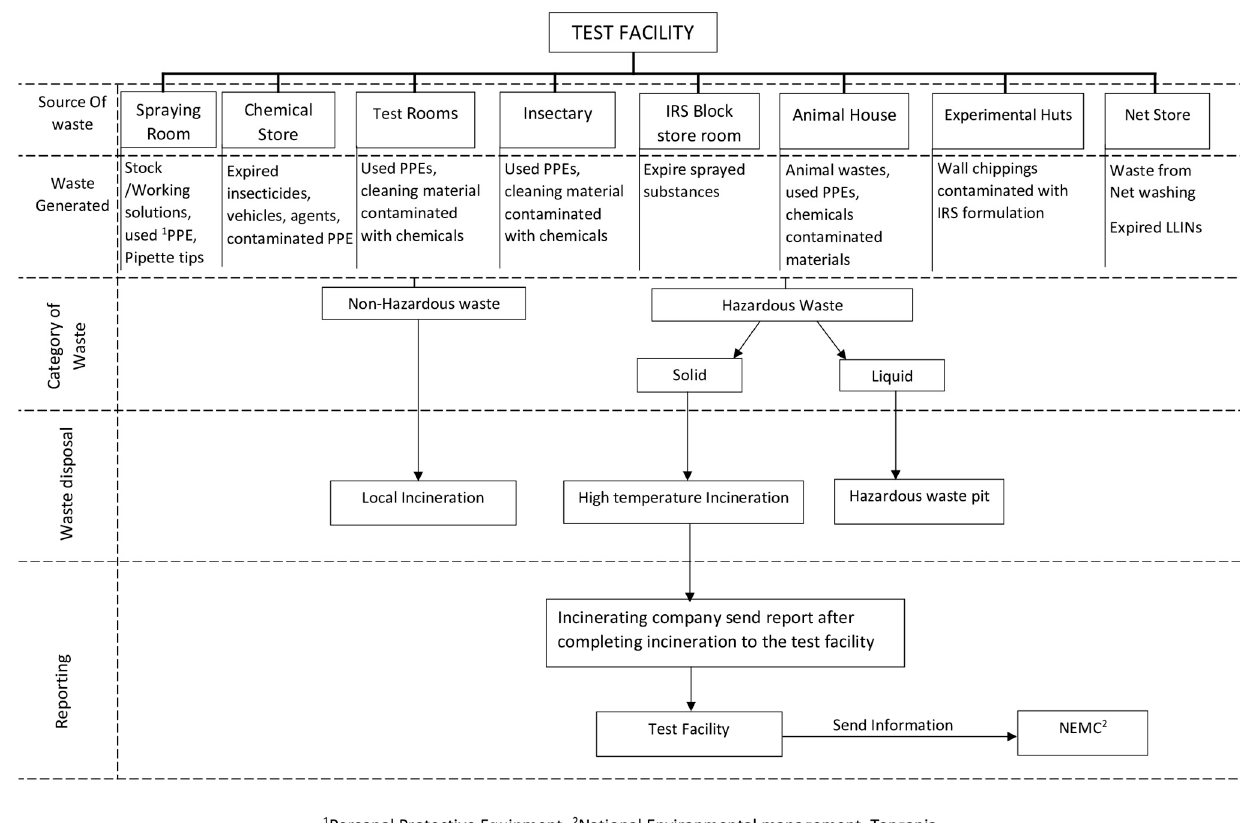
Figure 3. Test facility waste management pathway.